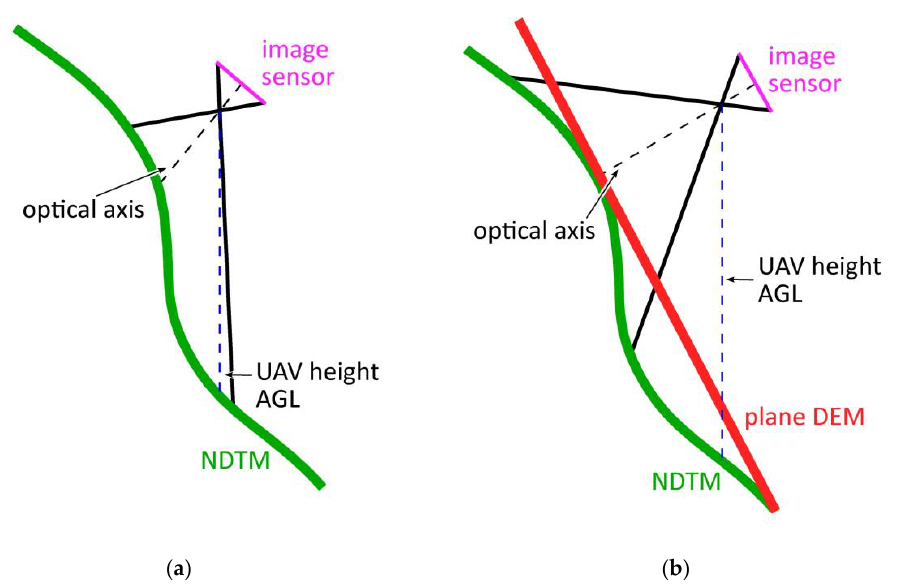
Figure 5. Oblique images acquired when the angle of inclination changes suddenly: ( a ) use of the national 5-meter digital terrain model (NDTM) for mission planning and ( b ) use of the constructed plane digital elevation model (DEM) for mission planning.